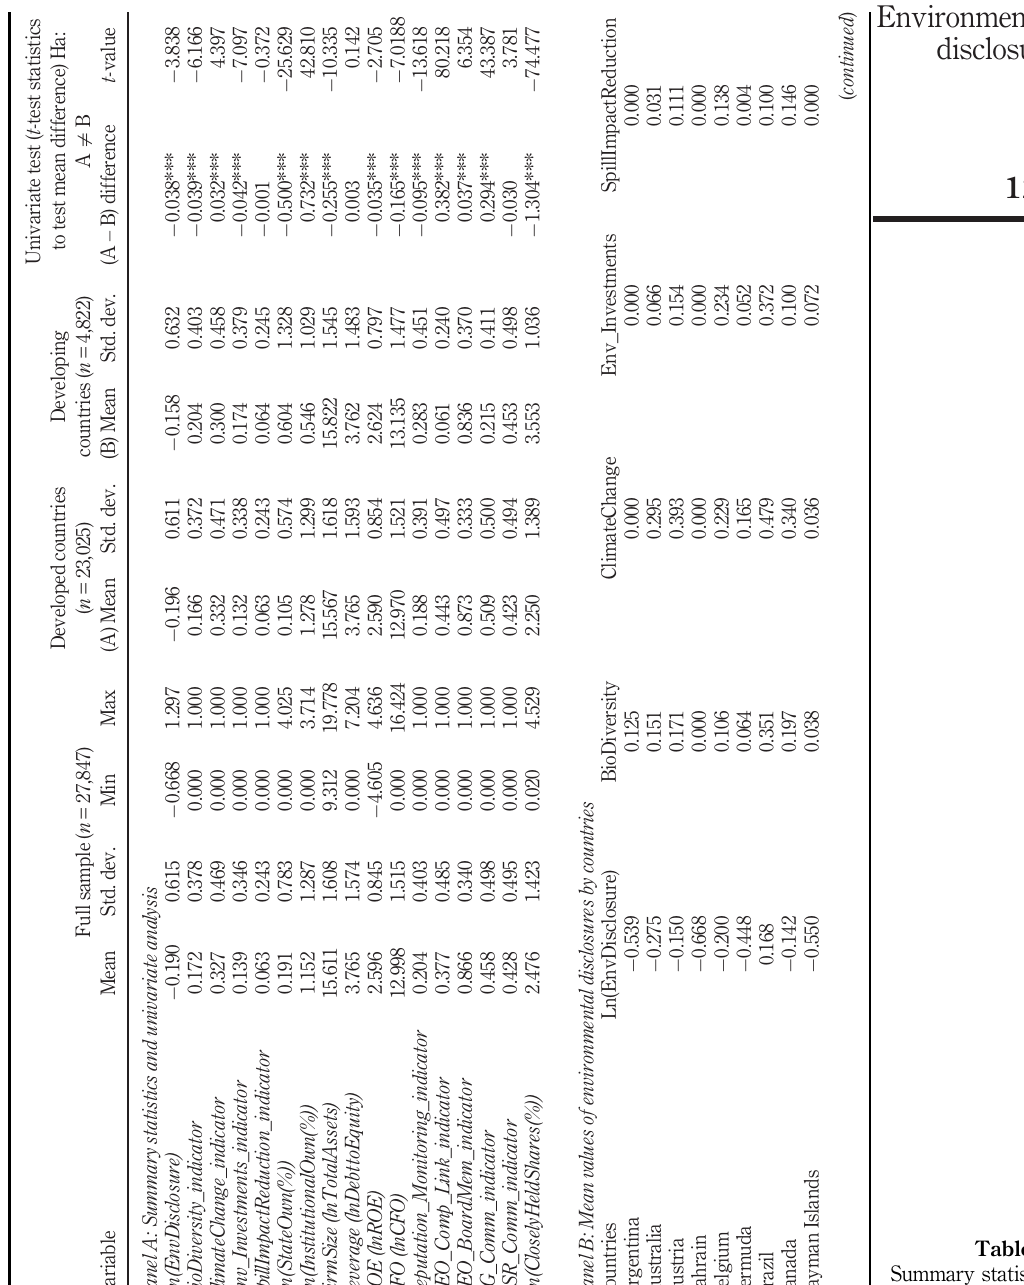
Table 3. Summary